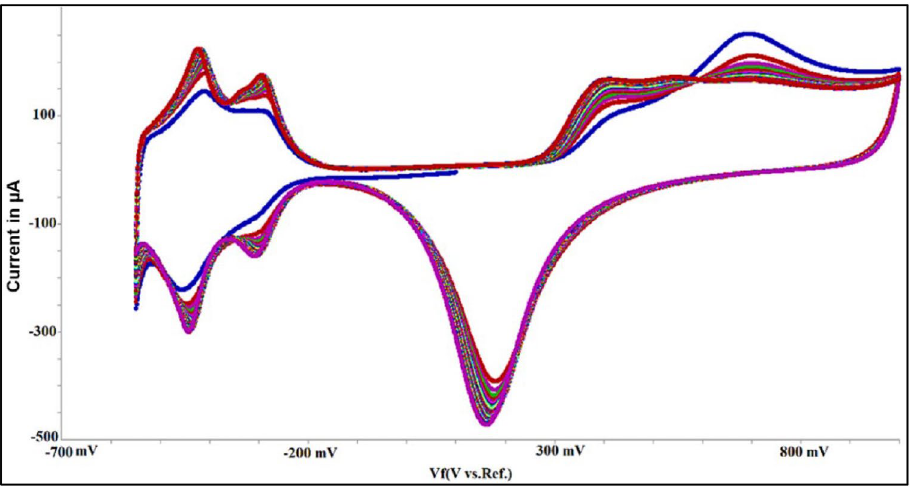
Figure 2. Cyclic voltammetry results at 500 mV/s and 50 cycles for